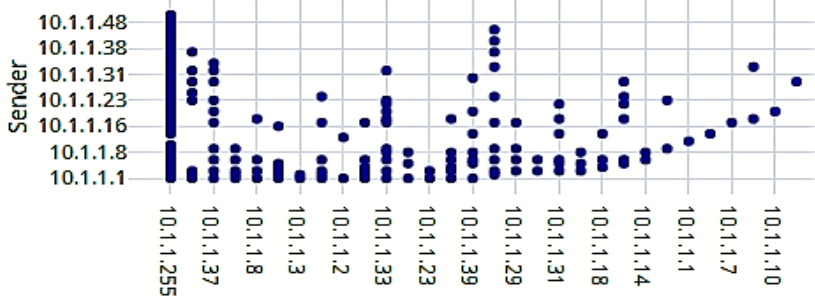
Figure 9. Communication at Node